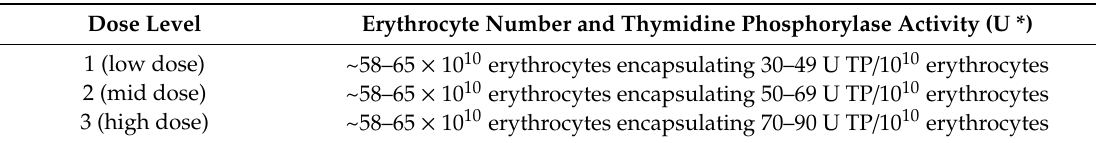
Table 2. Dose levels of EE-TP.